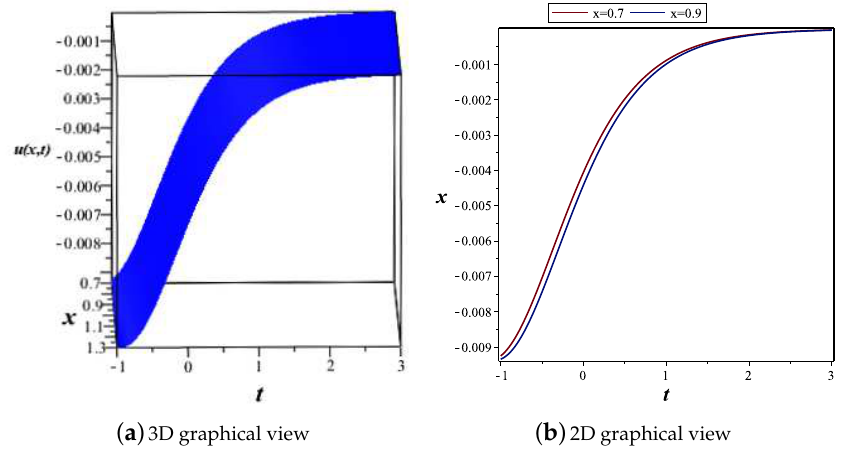
Figure 2. Graphical behavior of Equation (20) within interval 0.7 ≤ x ≤ 1.3 and − 1 ≤ t ≤ 3 (( b ) 2D plot for x = 0.7,